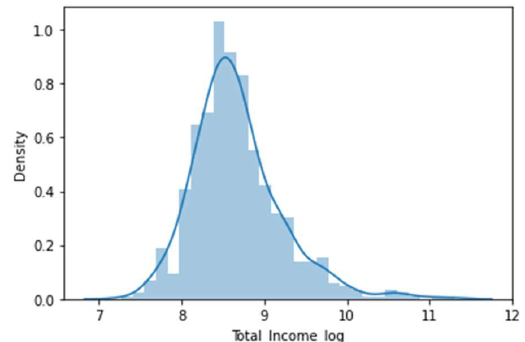
Fig. 1. Density vs Total Income Log